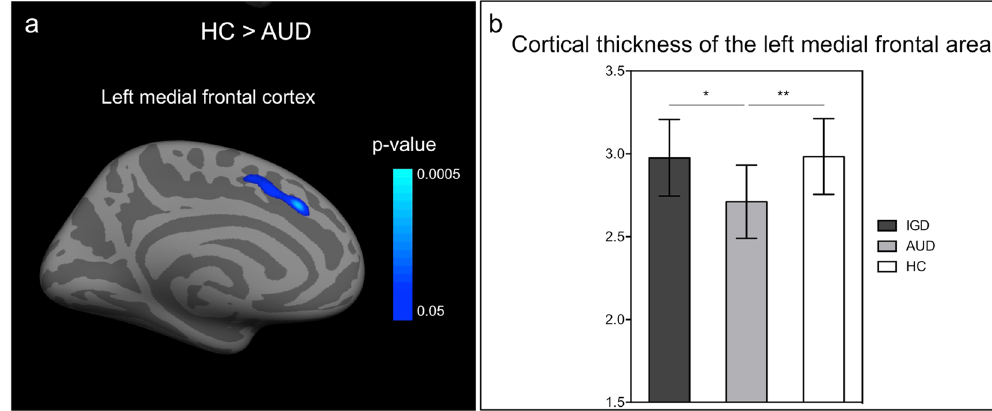
Figure 2. Result of cortical thickness analysis. ( a ) Significance maps of the group differences in cortical thickness in the participants with alcohol use disorder compared to healthy controls. ( b ) Average cortical thicknesses of the significant cluster for each group. Error bars denote standard error of the mean. * p ≤ 0.005; ** p < 0.001 HC, healthy control; AUD, alcohol use disorder; IGD, Internet gaming